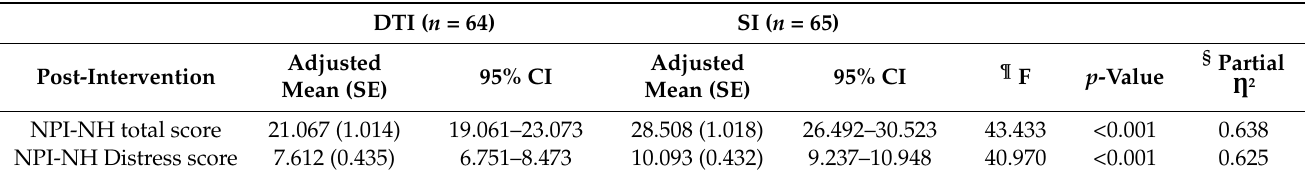
Table 2. Efficacy of DTI (experimental group) versus SI (control group) on post-intervention NPI-NH total and Distress score.